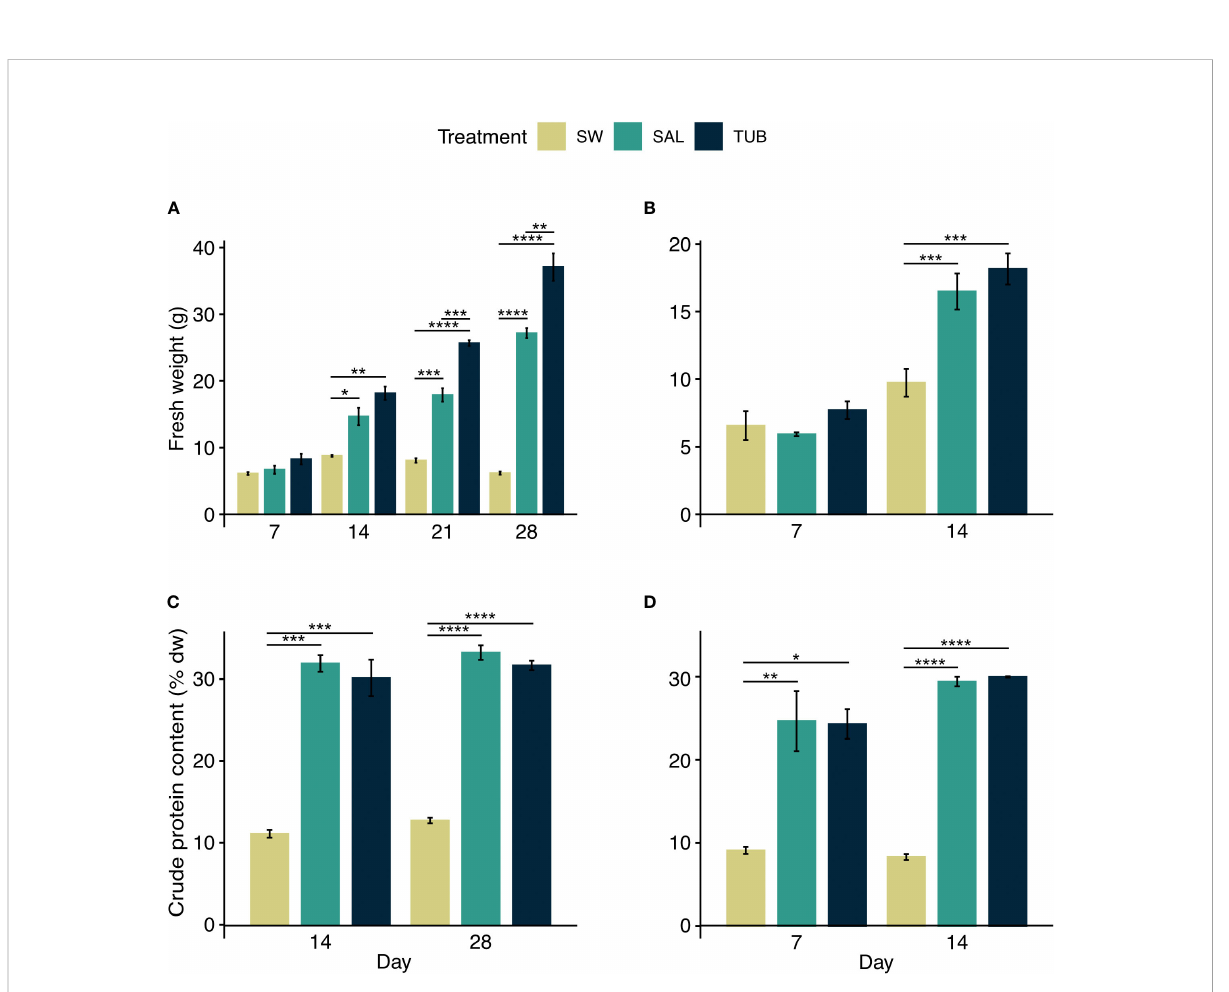
Signi fi cant p -values are indicated with italics. Data are visualized in Figure 1.